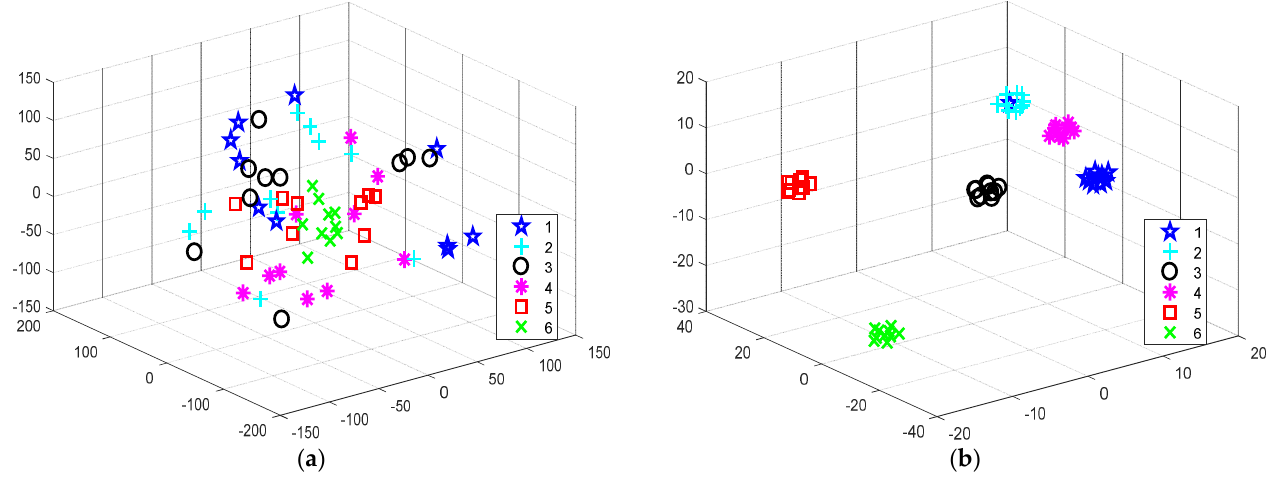
Figure 9. Feature visualization. ( a ) Feature visualization of raw signal; ( b ) Feature visualization of Softmax